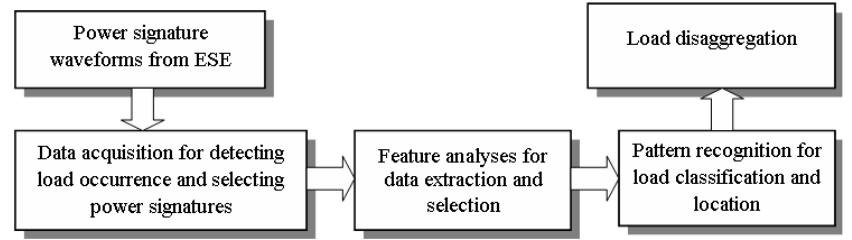
Figure 1. Schematic diagram of a non-intrusive load monitoring (NILM) system.